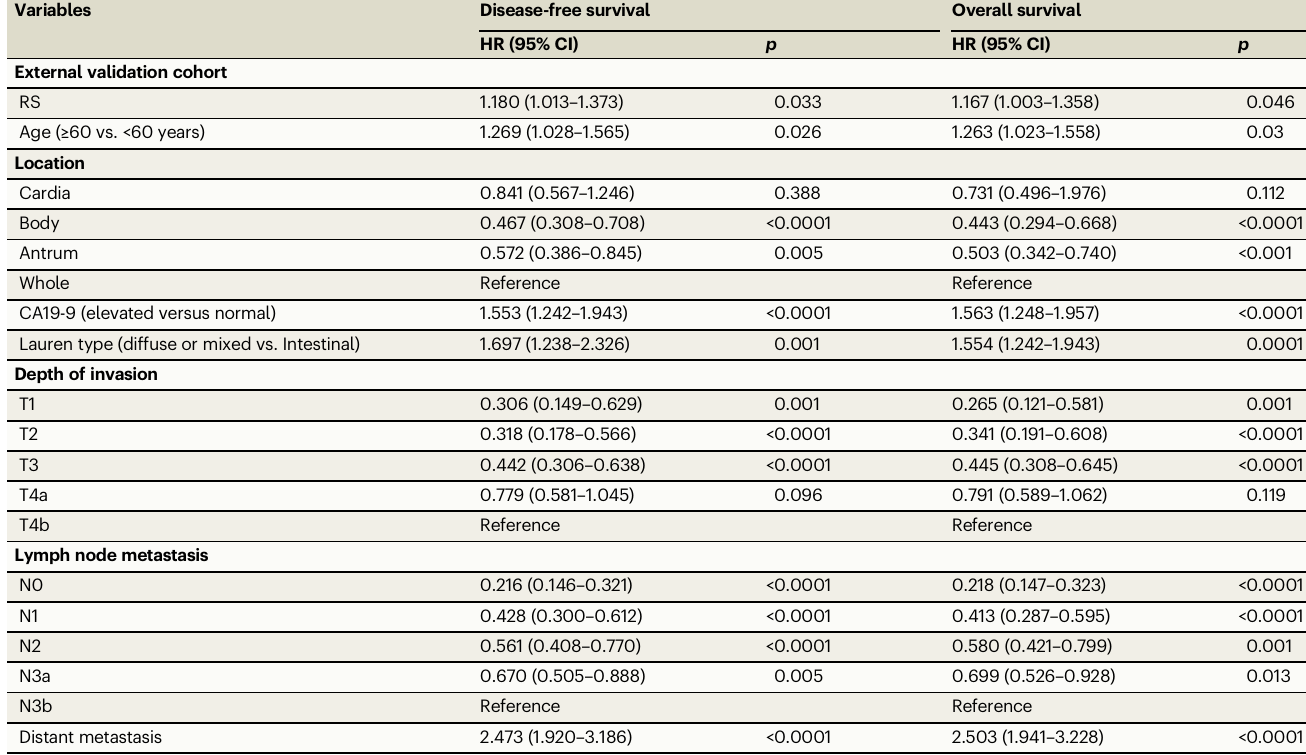
Table 3 | Multivariate Cox regression analyses for disease-free survival and overall survival in patients with gastric cancer in the external validation cohort